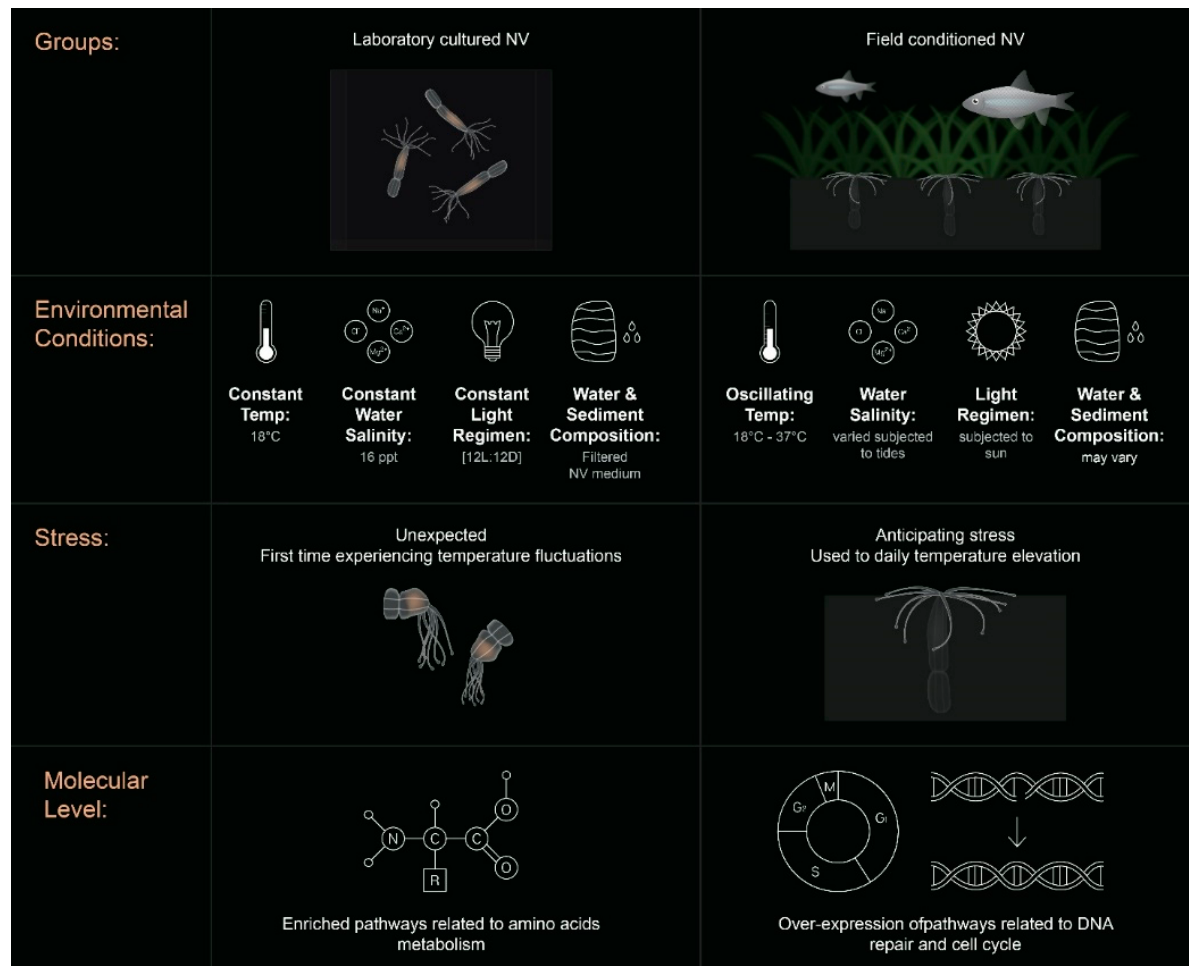
Figure 6. Conceptual summary. A scheme summarizing the different conditions experienced by lab-cultured N. vectensis ( left ) and field-conditioned N. vectensis ( right ) and our results. Among the conditions shown, the lab-cultured anemones were reared in diluted, filtered seawater (NV medium), and field-conditioned animals were exposed to sediments and naturally variable water chemistry.